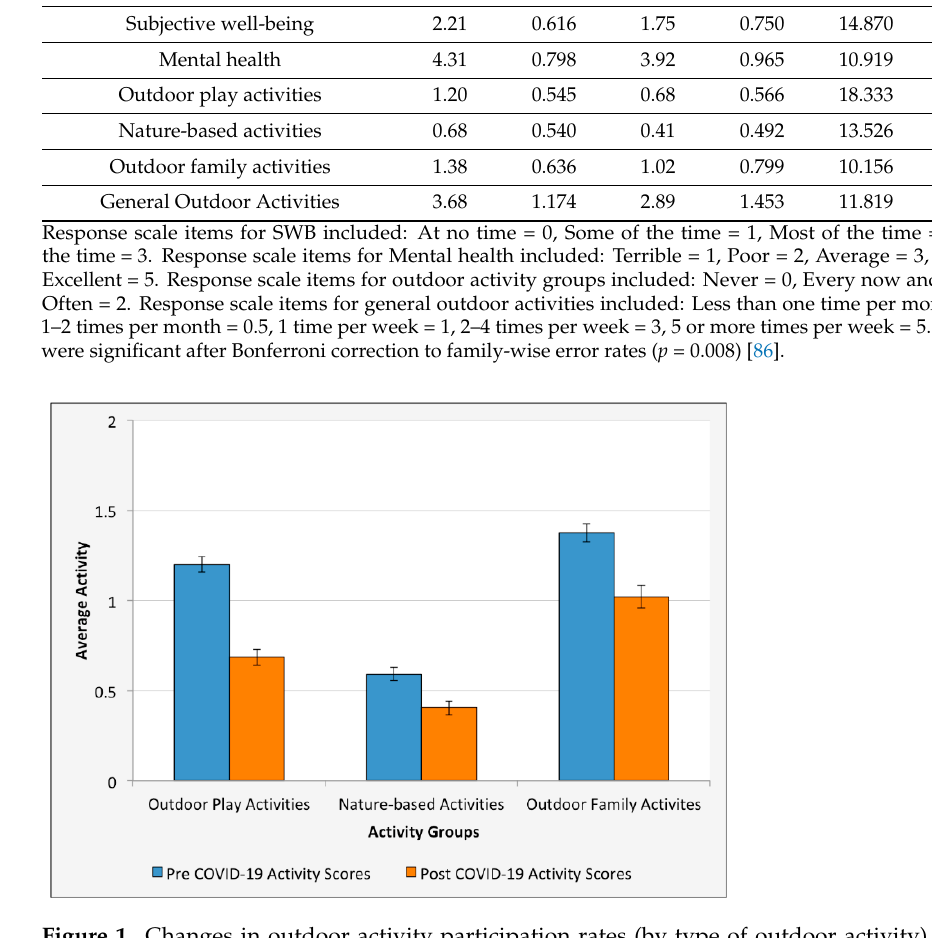
Figure 1. Changes in outdoor activity participation rates (by type of outdoor activity) pre- and post-COVID-19 pandemic for adolescents in the United States ( n = 624). Mean activity scores ranged from 0 (never participate) to 2 (often participate). from 0 (never participate) to 2 (often participate).